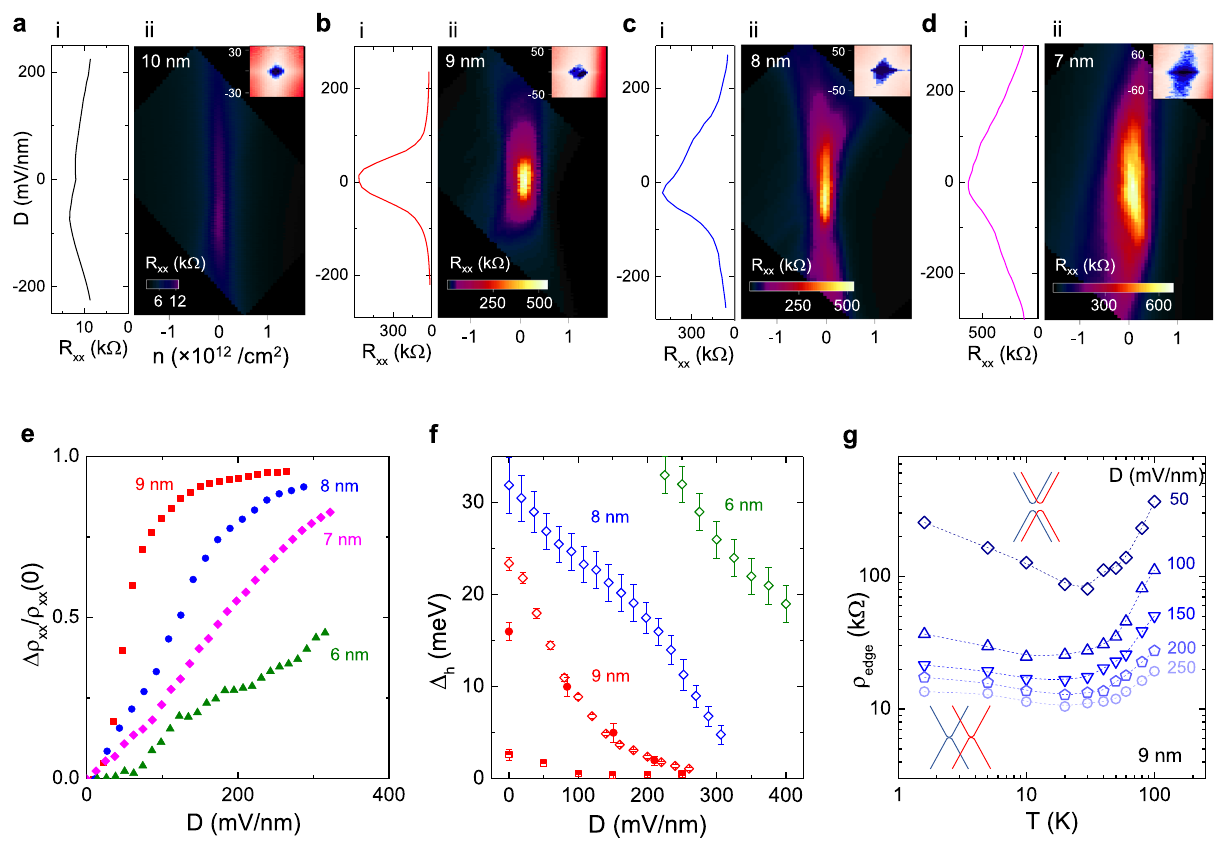
Fig. 4 | Surface gap inversion by external electric fi eld. (i) Color maps of R xx as functions of displacement fi eld ( D ) and total charge density ( n ) for the different thickness hBSTS in the order of ( a ) 10nm, ( b ) 9nm, ( c ) 8nm, and ( d ) 7nm. The D and n are calculated from dual-gate voltages as: D = 1 ε n = C bg 4 V bg + C tg 4 V tg .(ii)Linepro fi lesof R xx versus D fortherespective thickness takenat n ≈ 0cm − 2 .Insetin( a – d )is the d I /d V color maps asfunctionsof V b and V bg